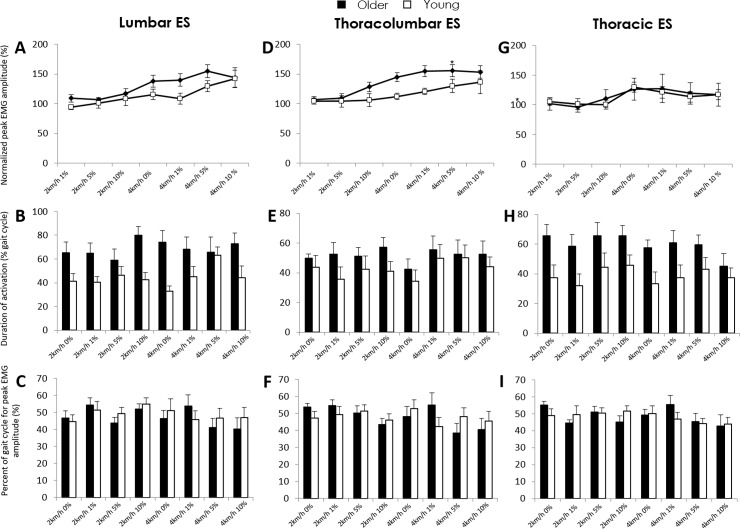
Surface EMG amplitude (mean and SD) in young and older adults for lumbar (left), thoracolumbar (centre) and thoracic (right) erector spinae during treadmill-walking under various speed-inclination conditions.A&D, Normalised (to 2km/h-0%) peak amplitude; B&E, Duration of activation as percent of the gait cycle; and C&F, Percentage of the gait cycle where peak amplitude occurred.